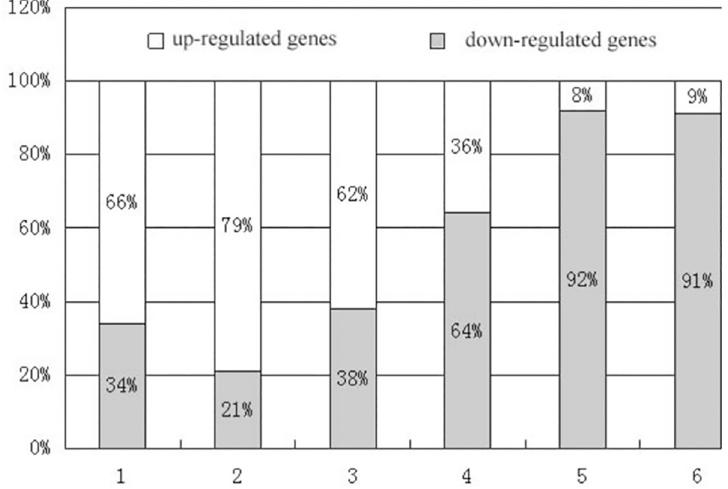
Fig 5. Proportion of up-regulated (white) and down-regulated (grey) differentially expressed genes at different stages of bract development. 1) Green tissue in bracts undergoing green-to-white transition; 2) White tissue in bracts undergoing green-to-white transition; 3) Fully white bracts; 4) White tissue in bracts during white-to-green reversion; 5) Pale green tissue during white-to-green reversion; 6) Fully pale green